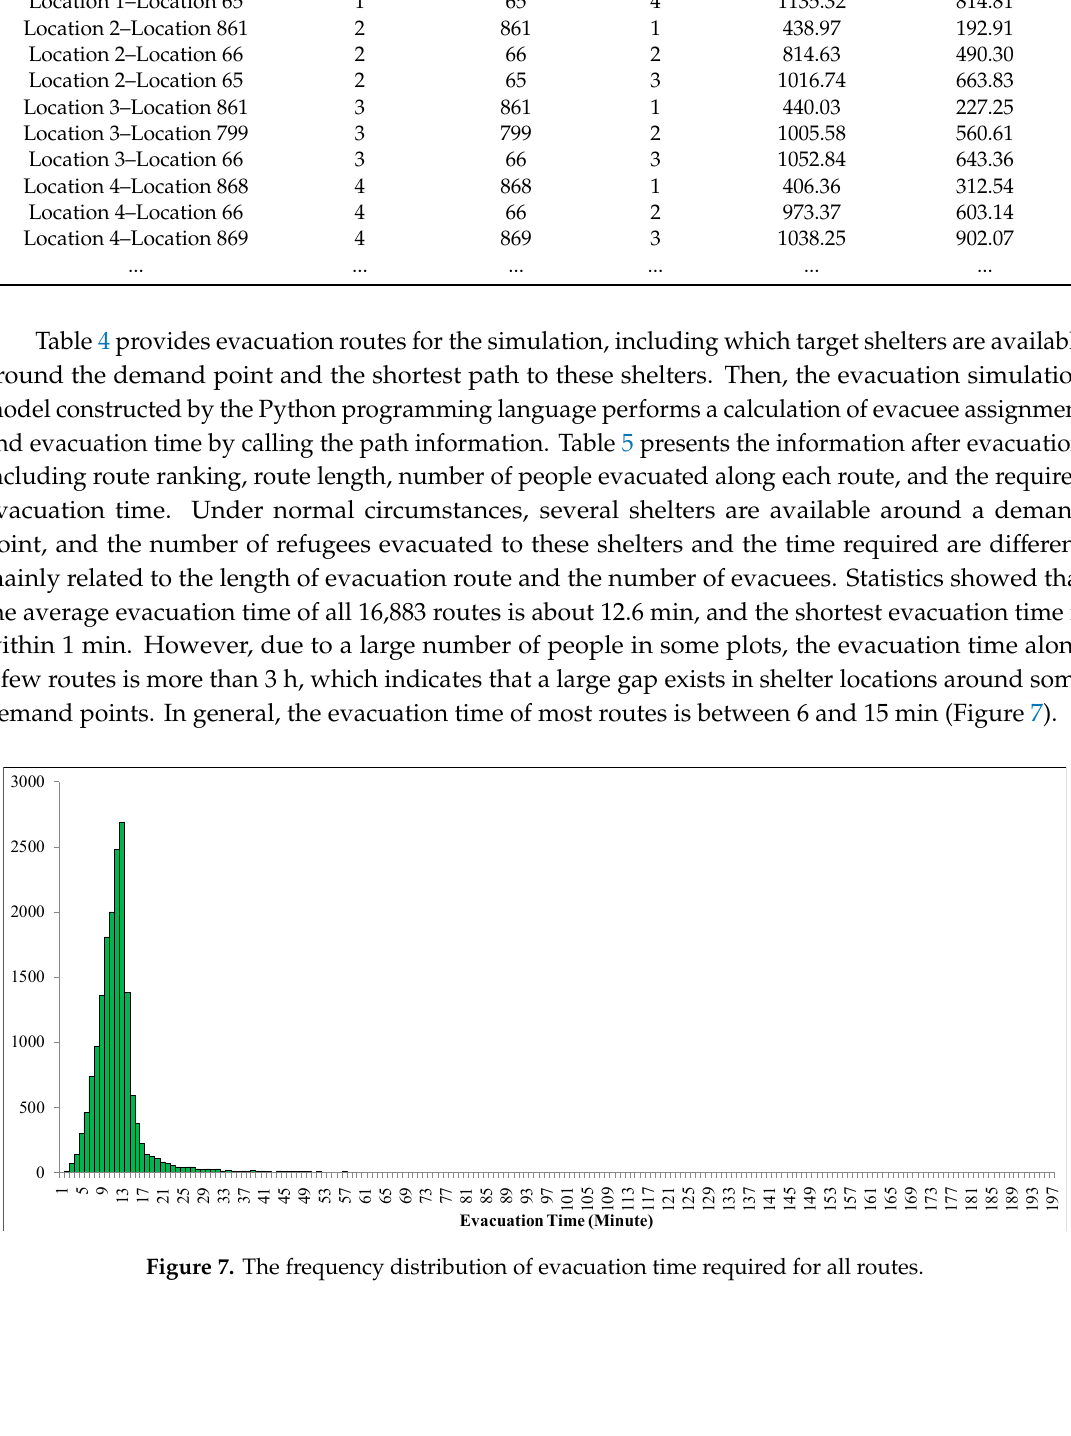
Table 6. Comparison between the number (N.) of evacuees accepted in each shelter and the capacity. Shelter Point ID